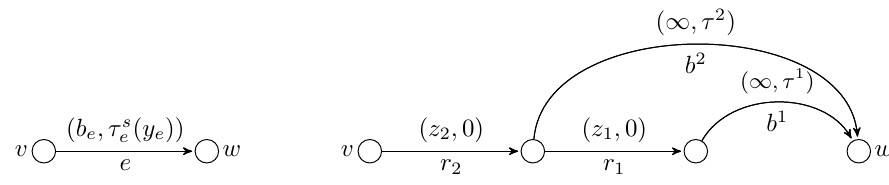
Figure 7: Expansion of e = ( v; w ) in the bow network with travel times 1 and 4, for at most z 1 and z 2 flow units. For given flow over time (cid:8) in the original network N with (IFDTT) step functions (cid:28) s e and time horizon T given by the flow rates (cid:8) e ( (cid:18) ) : A (cid:2) T ! R + , the flow over time (cid:8) B on the bow expansion of e is considered as in Definition